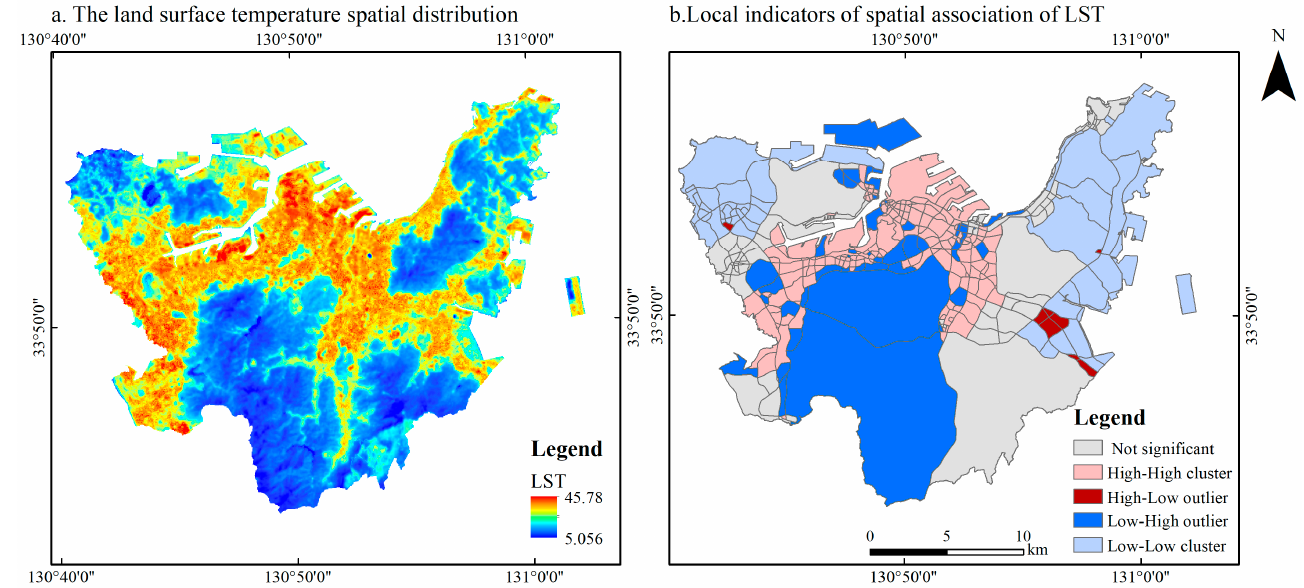
Figure 6. Land surface temperature spatial distribution of study area. ( a ) LST distribution, ( b ) LISA aggregation map.